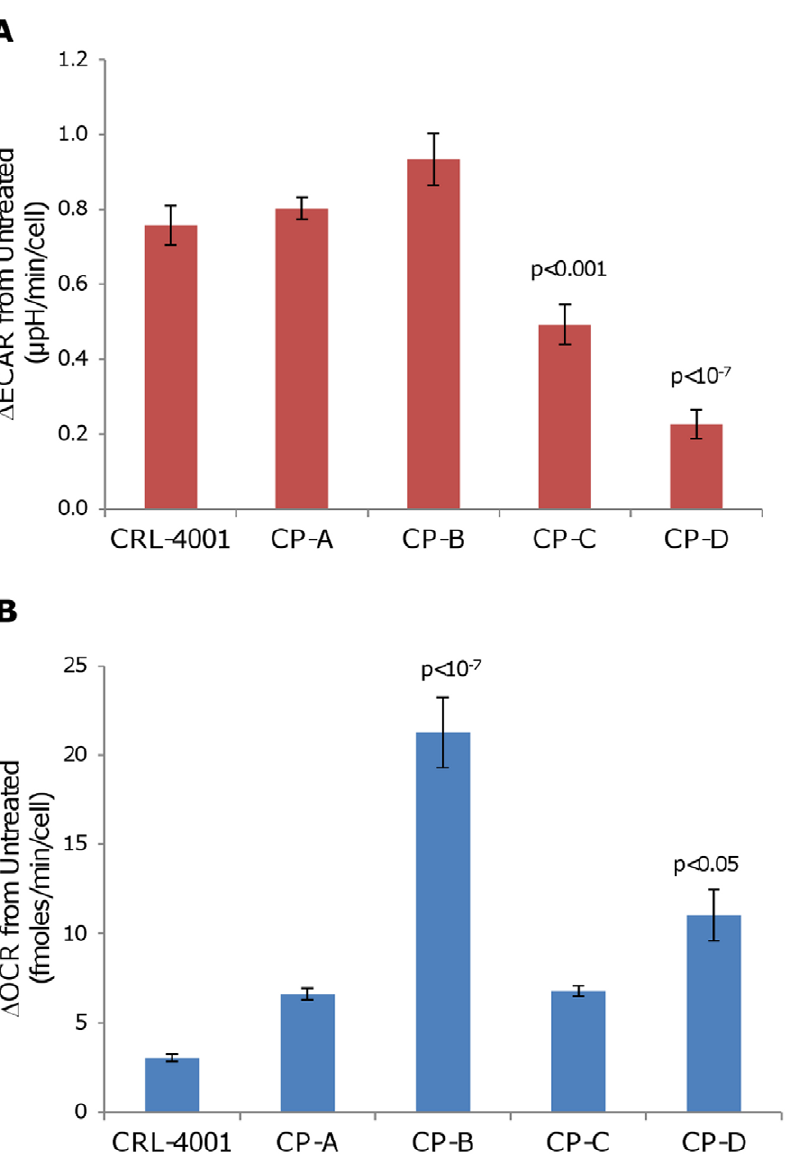
Figure 3. CP-C and CP-D display a lower ECAR increase after mitochondrial uncoupling than other cell lines. Following addition of 50 m M 2,4-DNP, total (a) ECAR and (b) OCR were measured on the Seahorse XF24 analyzer for each cell line and changes versus untreated baseline are plotted. Error bars represent standard-deviation of means between experiments (N=2–4). Each experiment consisted of 3–4 replicate wells per cell line with four serial measures performed on each well. p-values (Tukey-Kramer test) of statistically significant differences from CP-A are